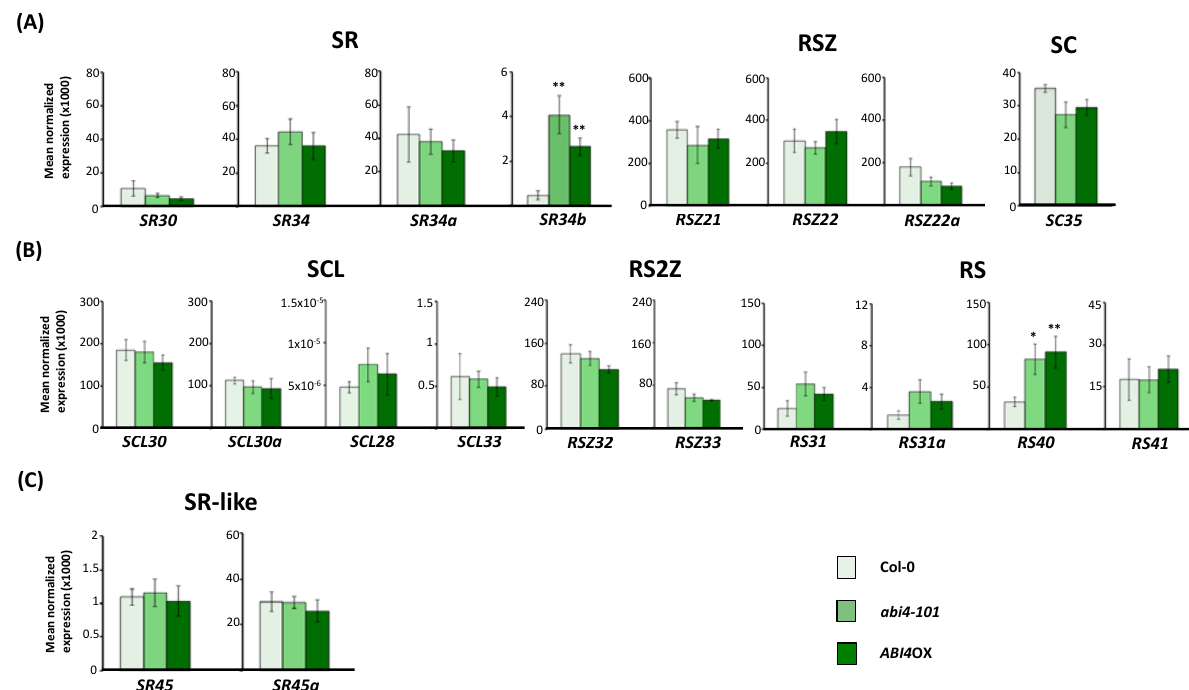
Figure 5. Expression of Arabidopsis SR and SR-like genes in the ABA-signaling abi4-101 mutant and ABI4 OX transgenic backgrounds. Real-time RT-qPCR analysis of total transcript levels of SR gene members of the mammalian ortholog ( A ) and plant-specific ( B ) subfamilies or of SR-like genes ( C ) in wild-type (Col-0), abi4-101 mutant and ABI4 OX transgenic seedlings. Results are from two independent experiments and values represent means ± SE ( n = 4). Asterisks indicate significant differences (* p < 0.05, ** p < 0.01; Student’s t -test) from the corresponding wild